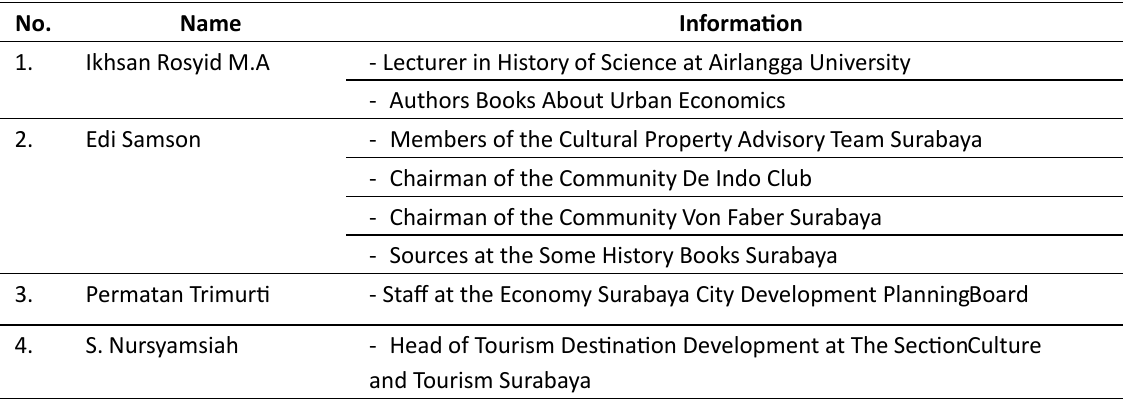
Table 1: Key Person Profile for